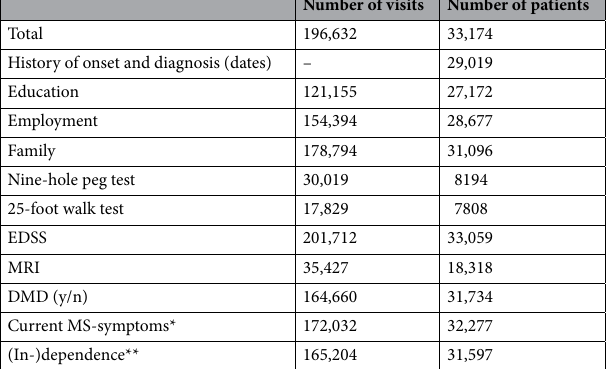
Table 3. Number of patients and visits by scale/category of information. DMD disease modifying drugs, EDSS expanded disability status scale, MRI magnetic resonance imaging. *Fatigue, paresis, bowel and bladder disturbances etc. **Care settings and the prescription/use of